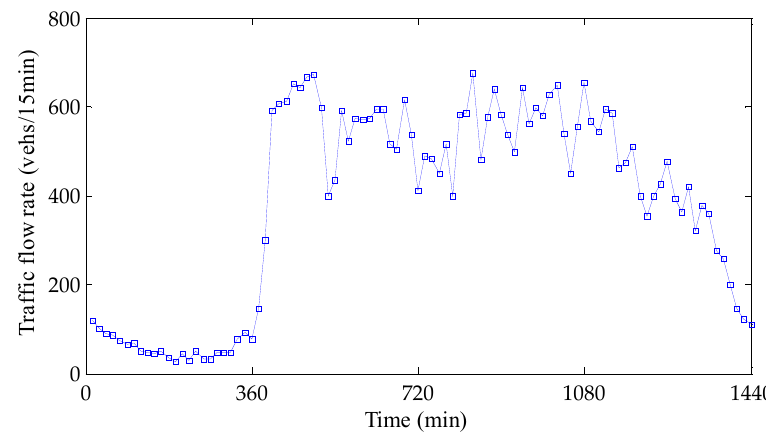
Figure 8. Tra ffi c flow rate based on GDD data. Figure 8. Traffic flow rate based on GDD data.